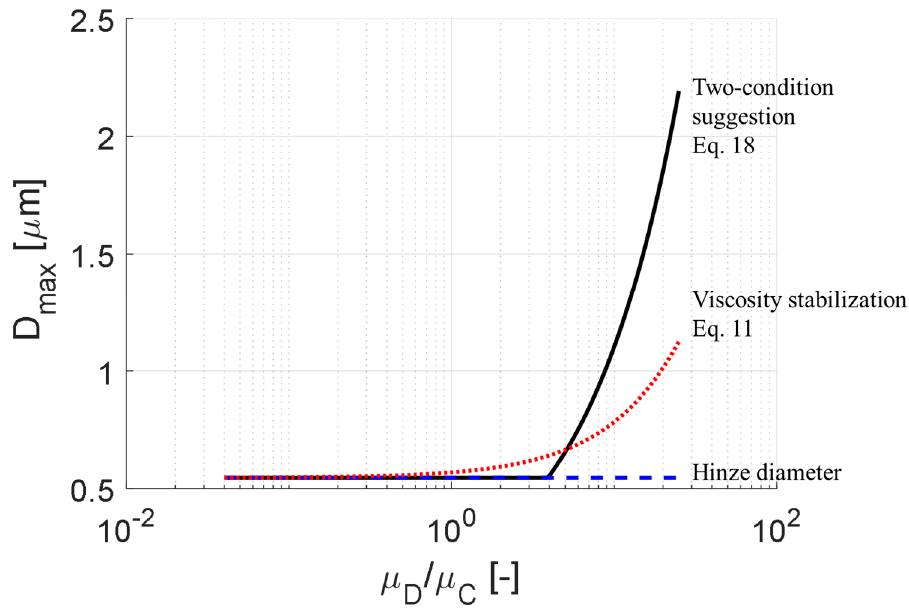
Figure 5. Maximum drop diameter according to the two-criterion extension (Equation (18)) (solid black line) compared to that of the viscosity-stabilization corrected Kolmogorov–Hinze theory (Equation (11)) (dotted red line) as a function of viscosity ratio ( µ D / µ C ).